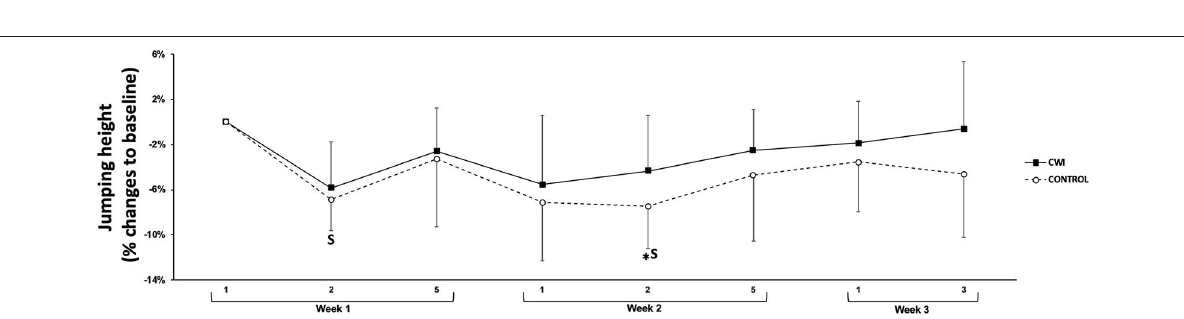
FIGURE 3 | Figure represents countermovement jump height changes to baseline ± SD across time points for CWI and Control groups. *Significant difference ( p < 0.05) from baseline in the Control group. Effect size ( d ) for between group comparison: S, Small.